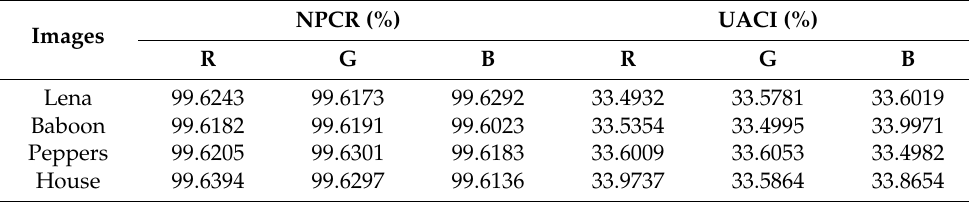
Table 5. Performance of plaintext sensitivity.